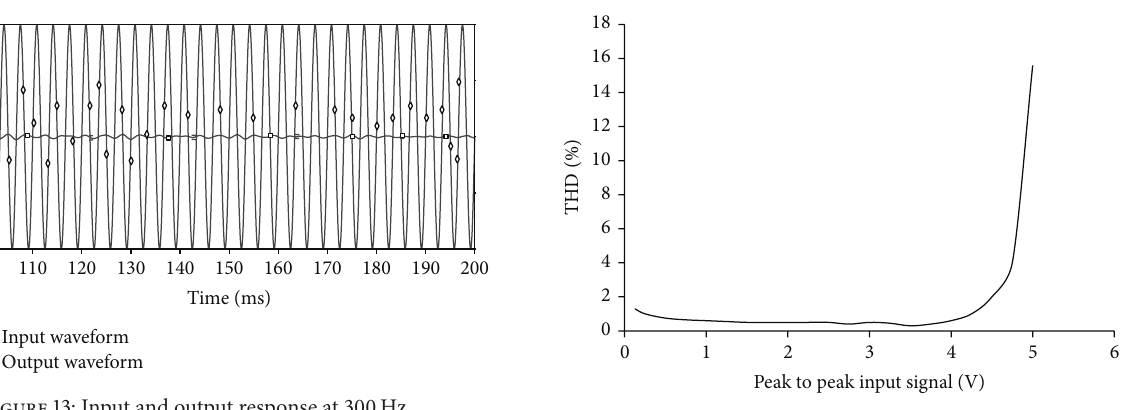
Figure 15: %THD of comb